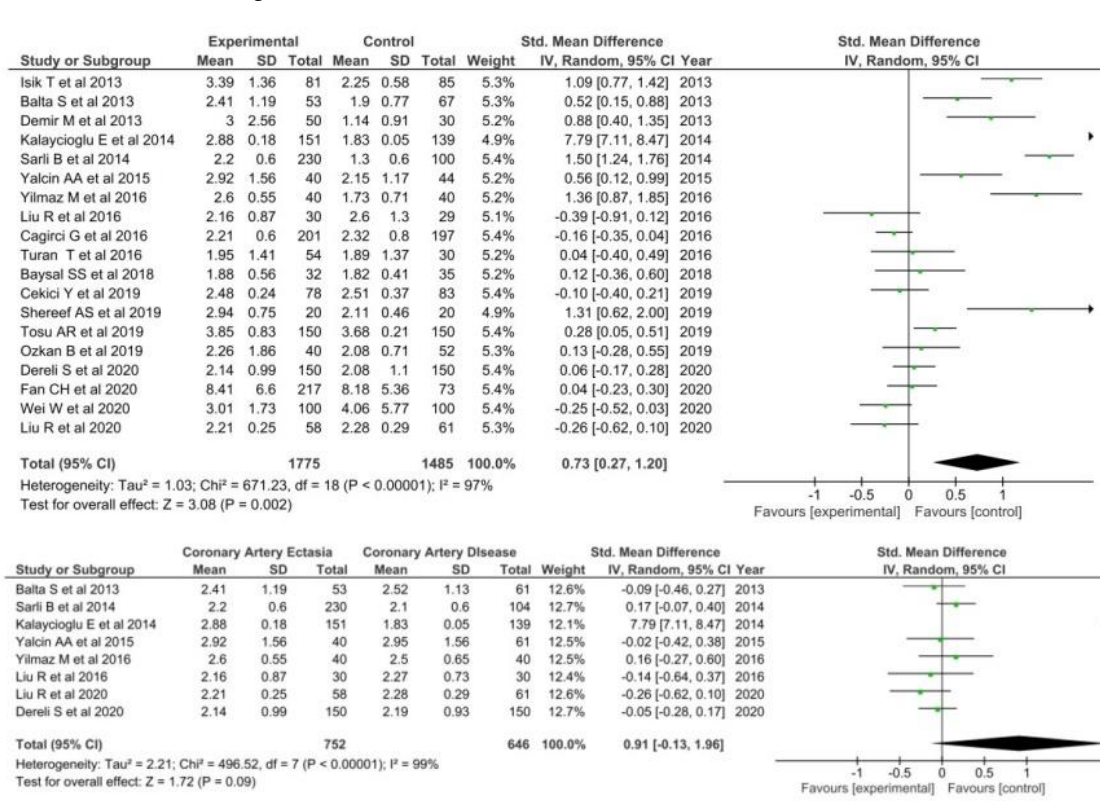
Figure 1. PRISMA flowchart.